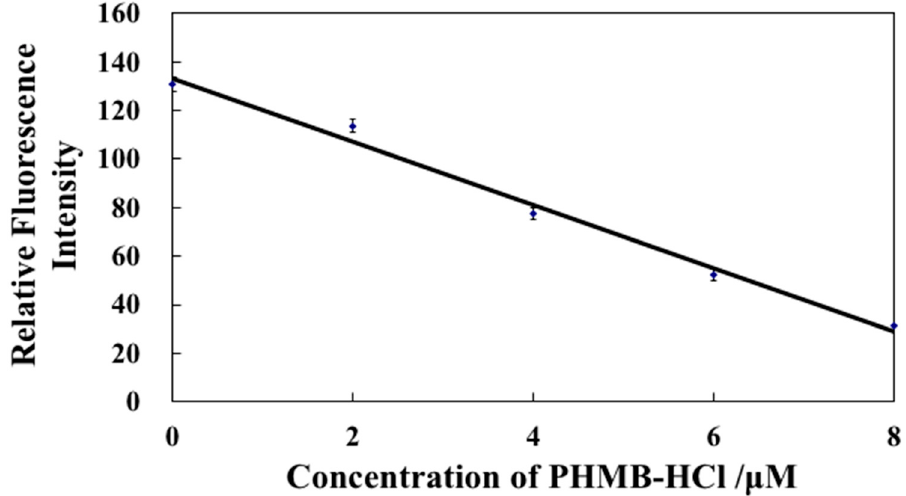
Figure 4. Calibration curve for polyhexamethylene biguanide hydrochloride (PHMB) in the presence of 20.0 µ M NaTPBF obtained by using an L-RB-based fluorescence optode.